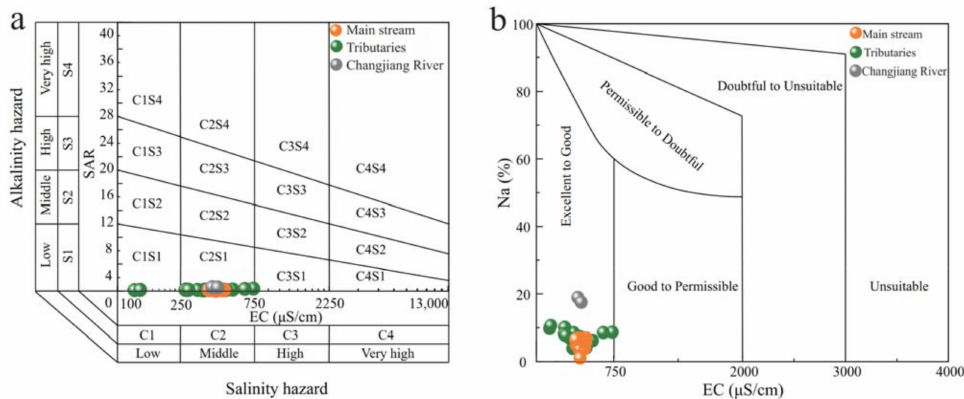
Figure 6. Irrigation water quality assessment alkalinity and salinity: ( a ) United States Salinity Labortory (USSL) diagram and ( b ) Wilcox